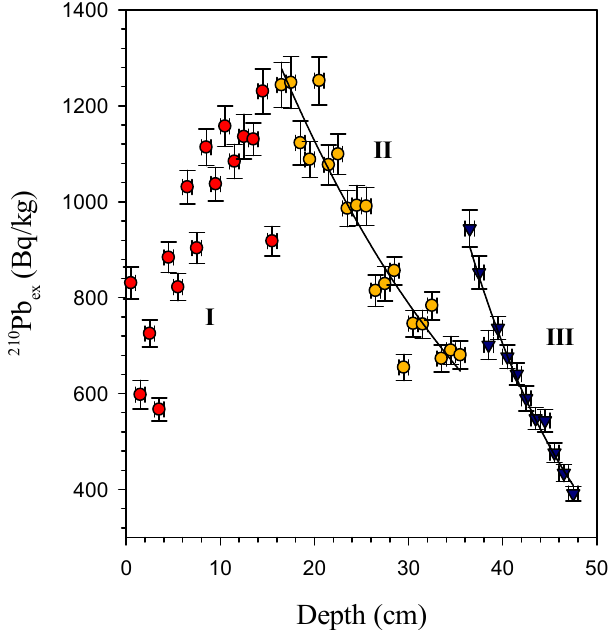
Figure 3. Radioactivity of 210 Pb ex against depth in core samples.